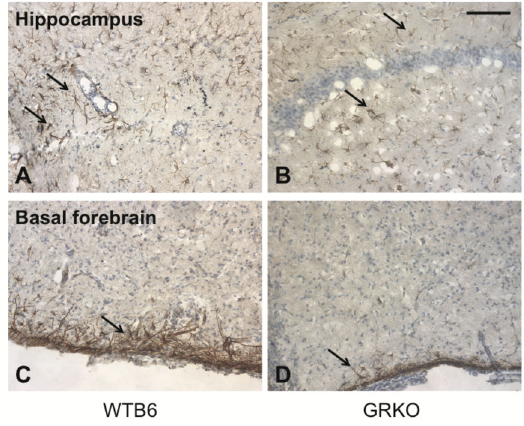
Figure 10. Immunohistochemical staining for IFN-gamma R2 in brains of WTB6 and GRKO mice. The hippocampus (A,B) and basal forebrain (C,D) of NSV-infected WTB6 (A,C) and GRKO (B,D) mice were examined 7 days after infection for expression of IFN-gamma R2. Frozen sections of the brains from 2 animals/group were immunostained with hamster monoclonal anti-IFN-gamma R2. IFN-gamma R2 was intensely expressed by cells in the brains of WTB6 mice (arrows). In GRKO mice that have a disruption in the IFN-gamma R1 gene, expression was less (arrows), but the distribution was